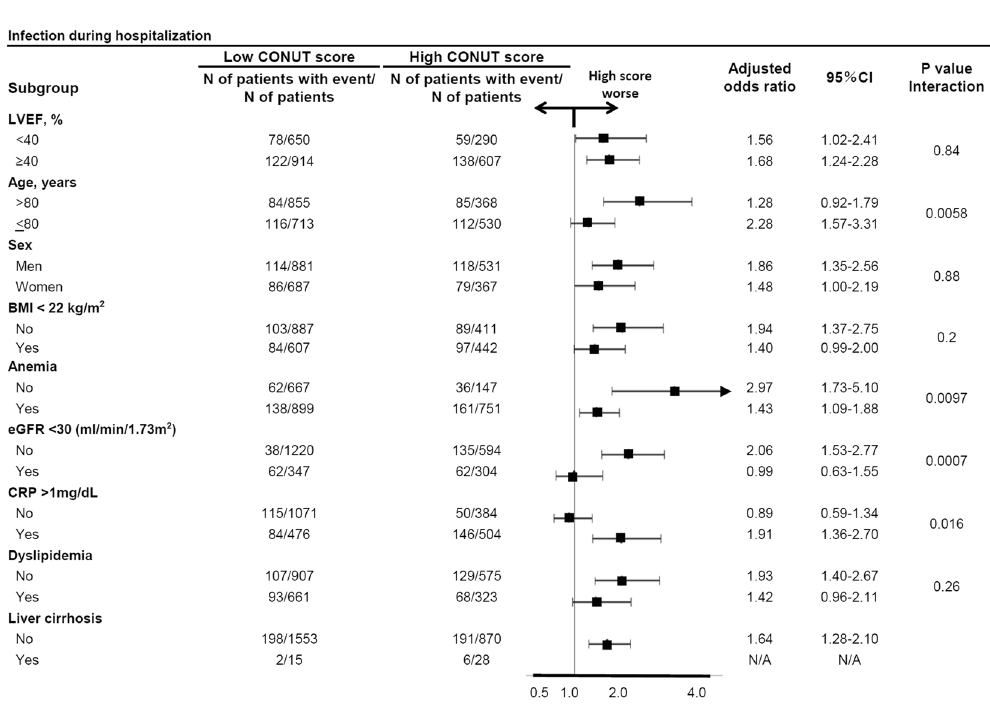
Figure 3. Subgroup analysis for the effect of the high versus low CONUT score on the primary outcome measure (in-hospital death). CONUT = Controlling Nutritional Status, CI = confidence interval, LVEF = left ventricular ejection fraction, BMI = body mass index, eGFR = estimated glomerular filtration rate, CRP = C reactive protein, N/A = not available.